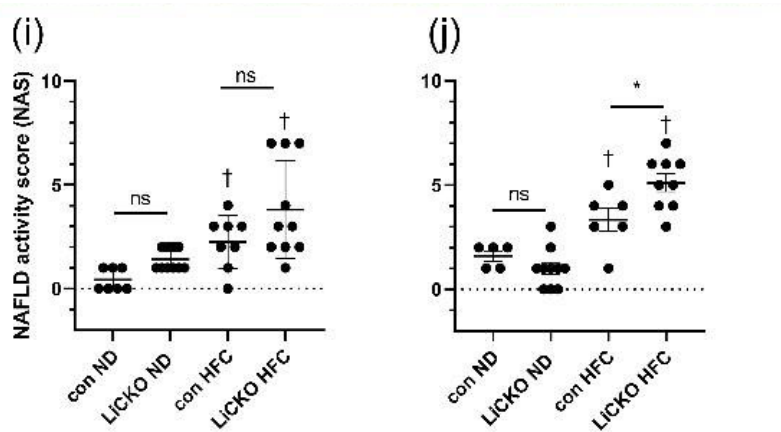
Figure 4. Liver histology. ( a , b , e , f ) No abnormal histological patterns were detected in mice on ND at 12 and 20 weeks of diet; ( c ) Control mice on HFC demonstrate mild steatosis (white arrow); ( d ) Steatosis is more aggravated in LiCKO at 12 weeks of HFC; ( g ) At 20 weeks of HFC, mild steatosis is present in control mice; ( h ) Further increased steatosis and inflammatory cells (black arrow) can be seen at 20 weeks of HFC in LiCKO; ( i ) NAFLD activity scores (NAS) at 12 weeks of diet; ( j ) NAFLD activity scores (NAS) were significantly increased in LiCKO mice at 20 weeks of HFC diet compared to controls on HFC diet. * p < 0.05 difference between con and LiCKO on same diet; † p < 0.05 difference between ND and HFC for con or LiCKO; ns = non-significant.